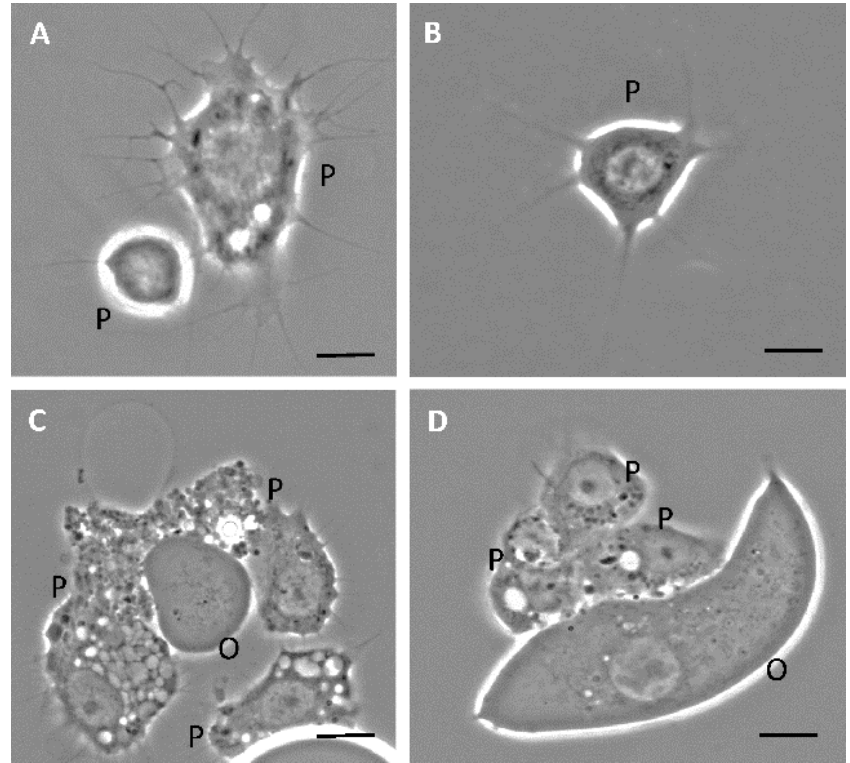
Figure 1. ( A – D ) Phase contrast microscopy of fifth instar nymphs hemocytes of Dipetalogaster maxima . P, plasmatocyte; O, oenocyte. Bars: 10 μ m.